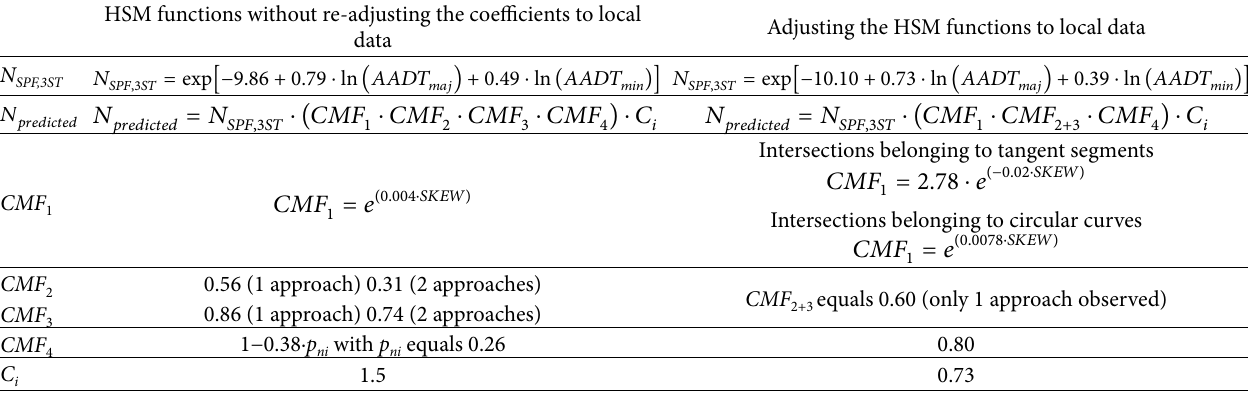
, 𝑁 , CMFs and C compared with the HSM solutions. i 𝑆𝑃𝐹,3𝑆𝑇 𝑝𝑟𝑒𝑑𝑖𝑐𝑡𝑒𝑑